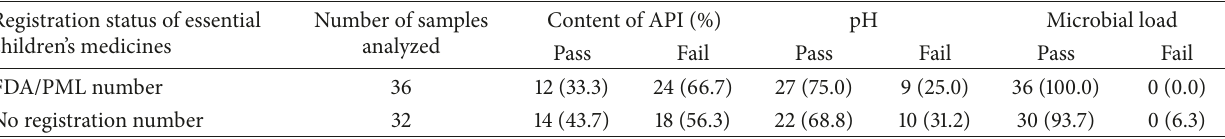
Table 5: Summary results of the quality of sampled essential children’s medicines with and without Food and Drugs Authority, Ghana, and/or Product Manufacturing License (PML) numbers.